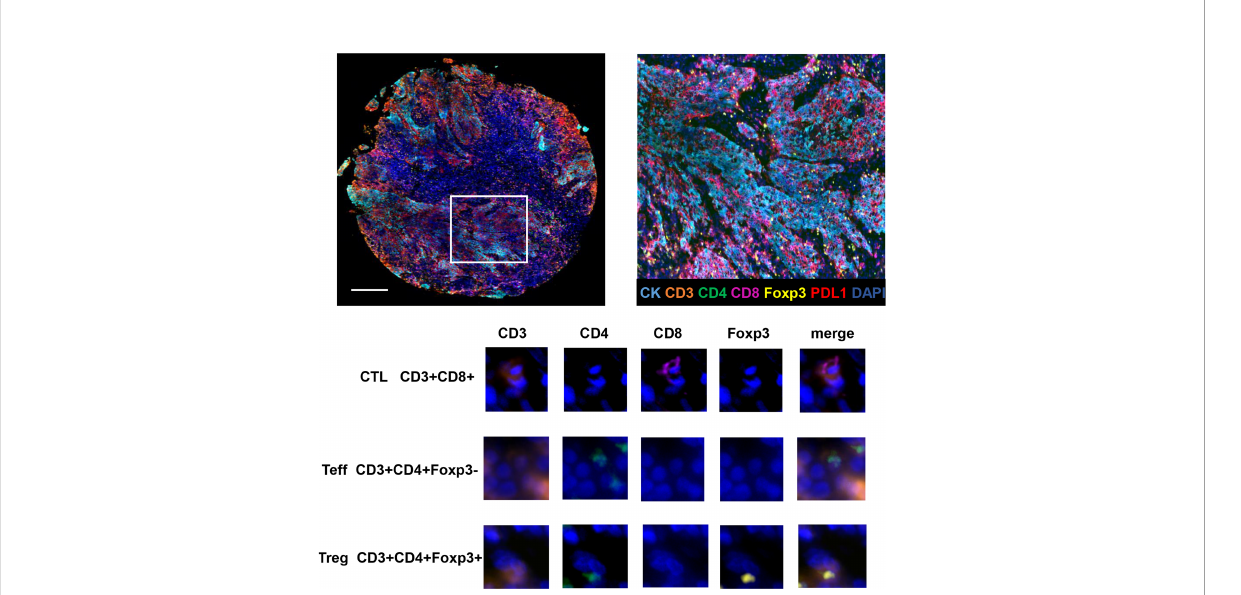
FIGURE 1 Opal seven-color multiplex analysis of NPC tumor tissue identi fi es speci fi c TILs subtypes. Representative image of multiplex fl uorescence staining and the enlarged subsection are displayed on the top panel. In the lower panel, images for unmixed single marker of CD3, CD4, CD8 and Foxp3 are presented in the left four columns. The right column demonstrates merged fl uorescence image of various combination of four markers, resulting in the identi fi cation of typical TILs phenotypes such as CTLs, Teffs and